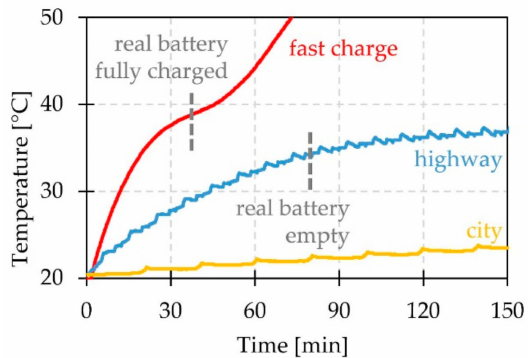
Figure 22. Temperature of individual battery cells during fast charging (active cooling) and two different driving situations (passive